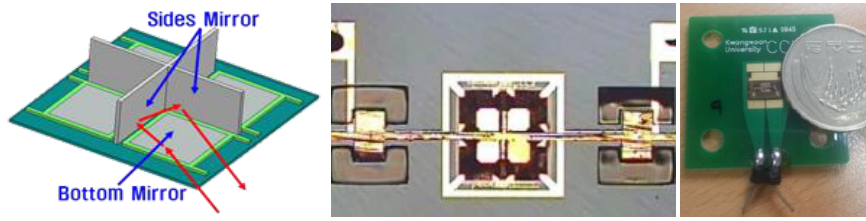
Figure 14. Tested MEMS CCR structure and design.